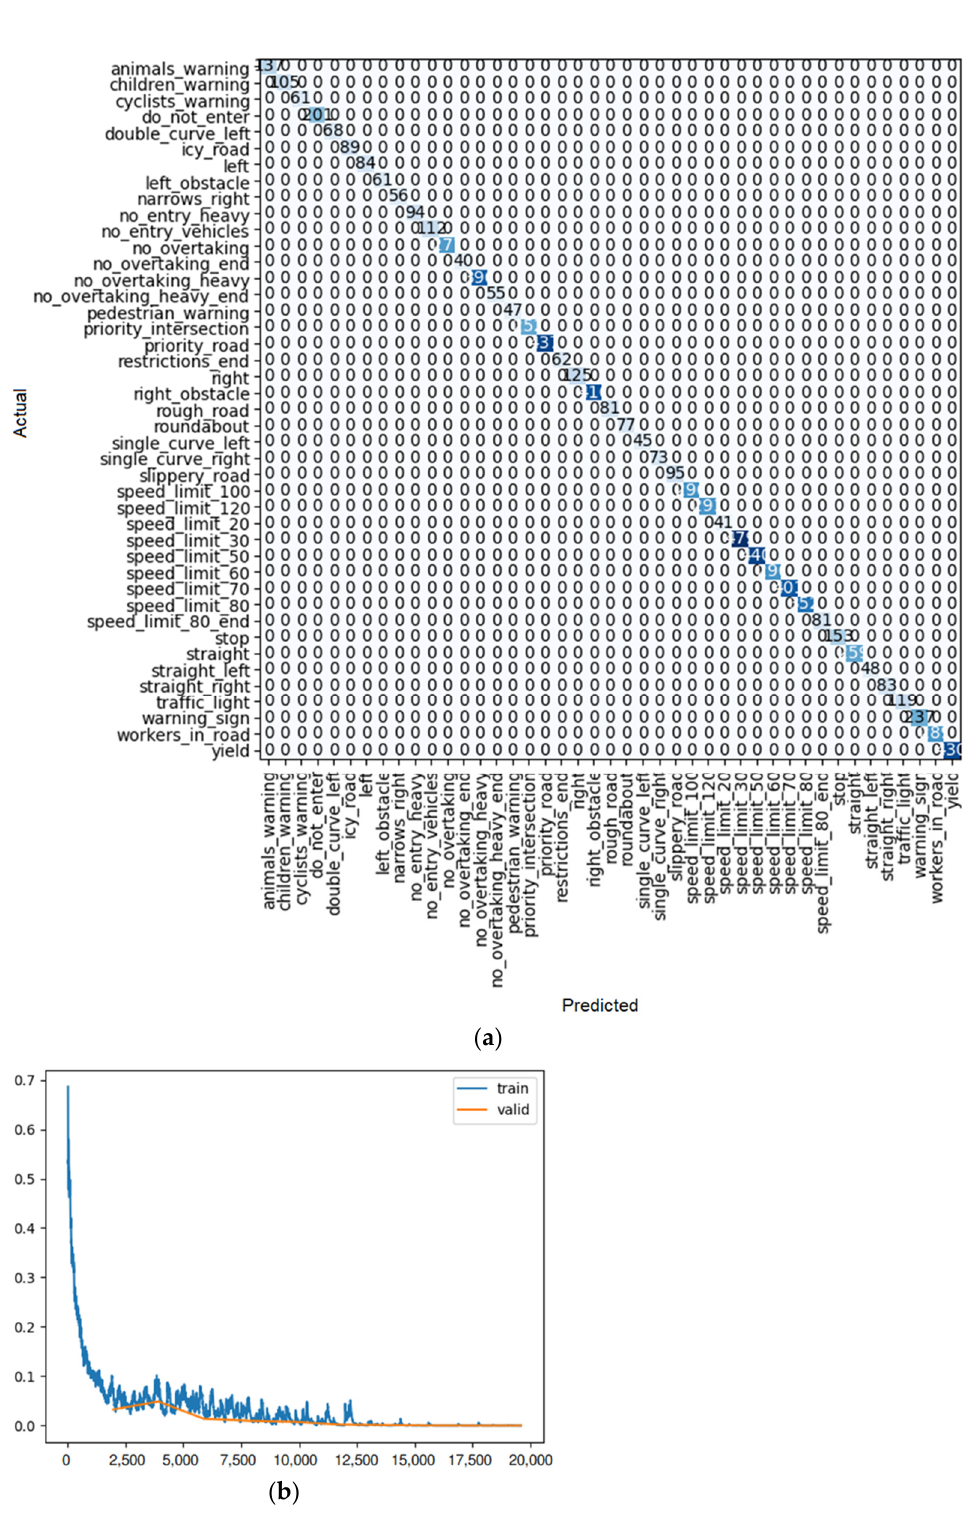
Table 9. Results of the XResNet50. Epoch